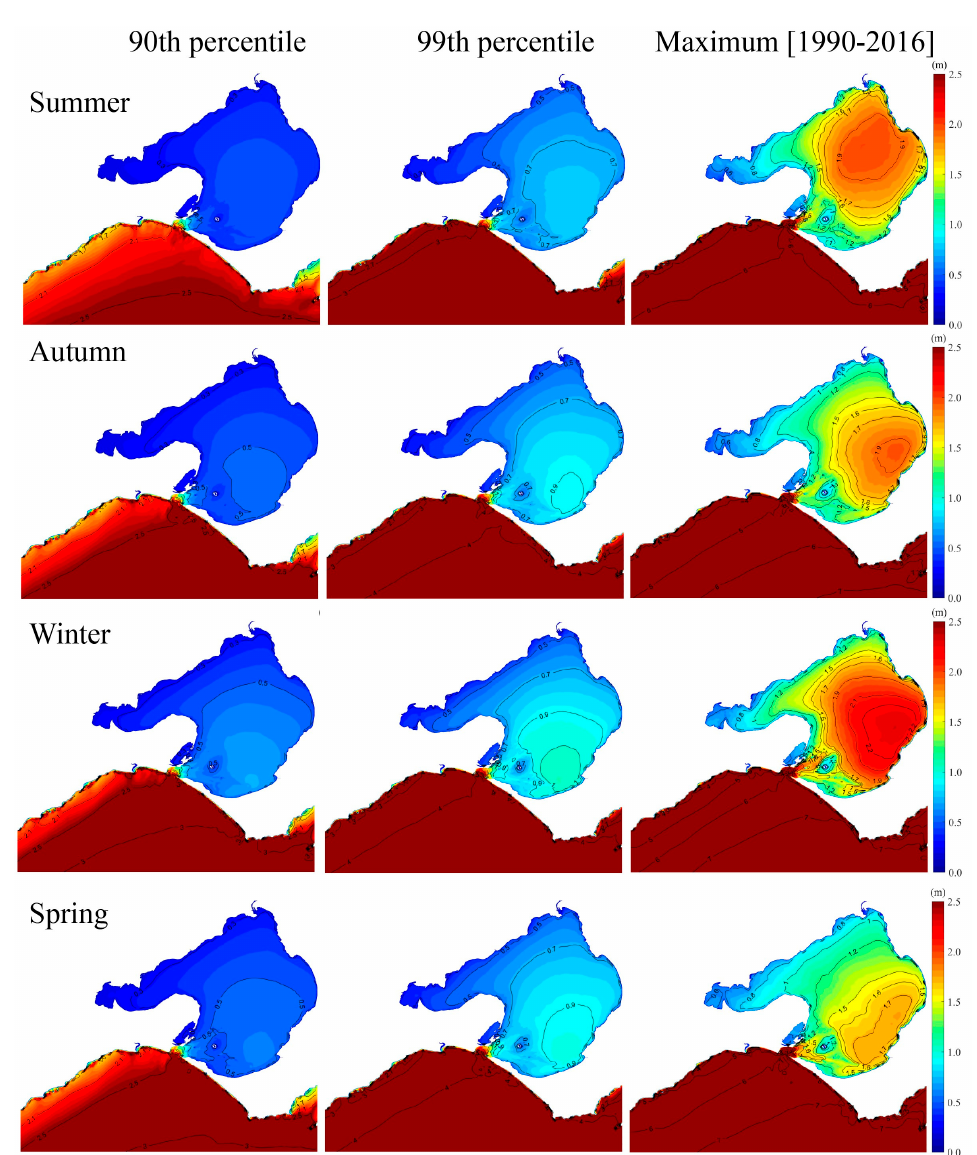
Figure 11. Maps of spatial and seasonal variations in SWH estimated for the 90th and 99th percentiles and maximum values over 27-years hindcasts.